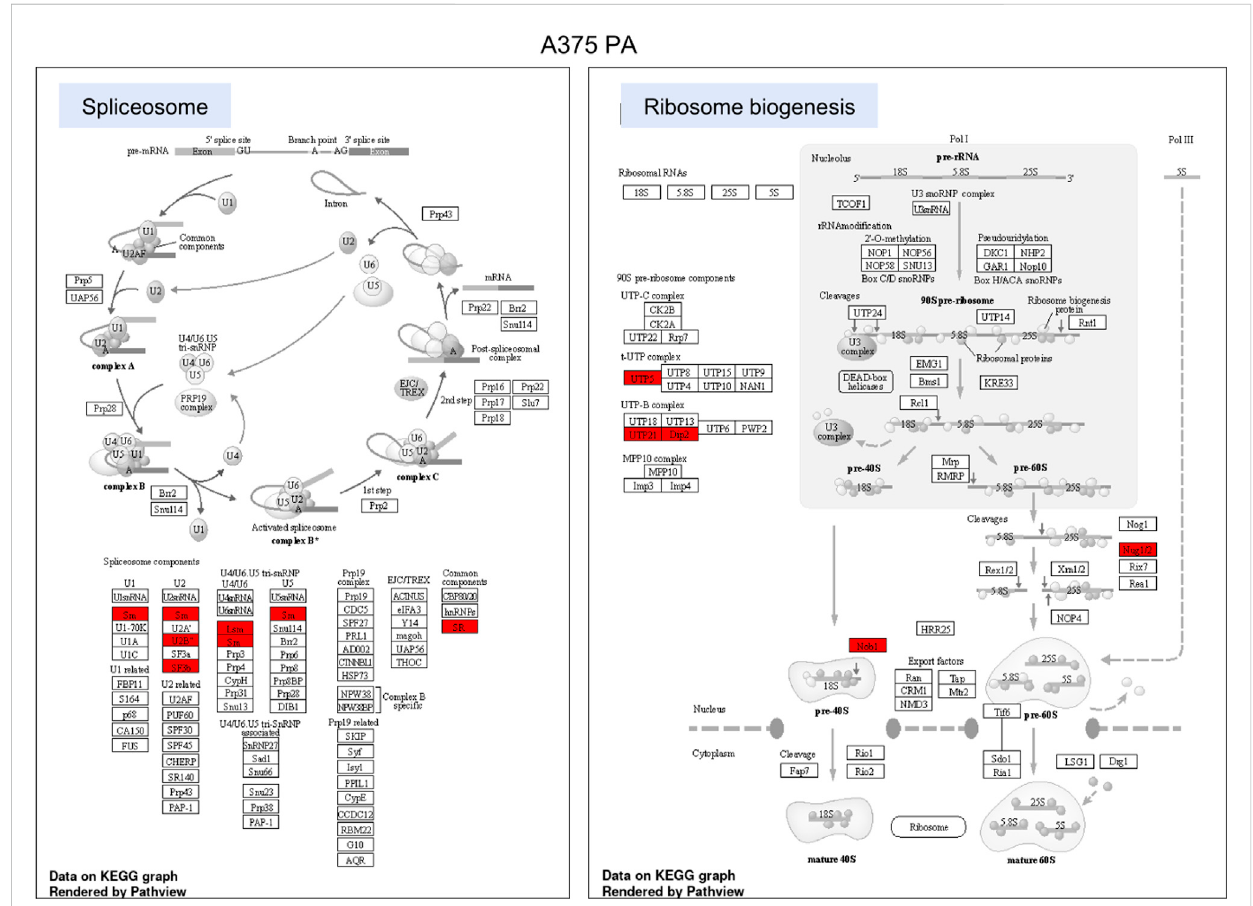
FIGURE 5 Gene Ontology (GO) Enrichment Analysis of signi fi cantly upregulated proteins in A375 parental ad A375 YB-1 knock-out cell lines. The analysis and visualization were performed in Enrichr web (https://maayanlab.cloud/Enrichr/) (Chen et al., 2013; Kuleshov et al., 2016). The list of upregulated proteins for each cell line was used to generate the results. The top enriched molecular function and cellular components are visualized for each cell line. All results are sorted by p -value ranking. Abbreviations: GO — Gene Ontology, PA — parental; KO —